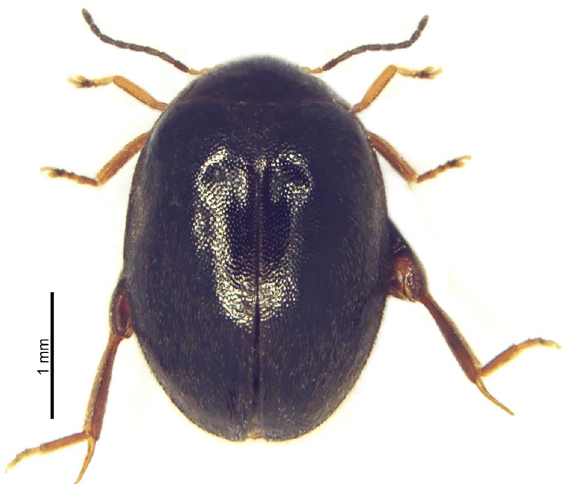
Figure 1. General appearance of the marsh beetle Scirtes hemisphaericus (Coleoptera: